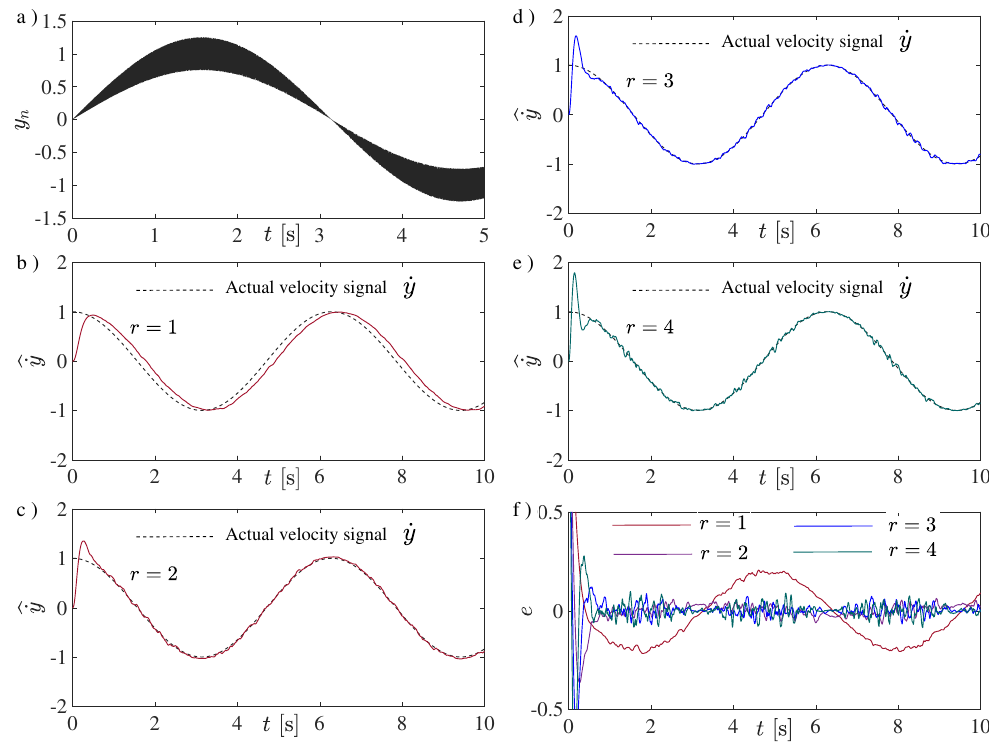
Figure 3. ( a ) Measured output signal contaminated with undesirable noise. Polynomial differentiation using Taylor series expansions: ( b ) first order, ( c ) second order, ( d ) third order, ( e ) four order. ( f ) Estimation error e = ˙ y − (cid:98) ˙ y .